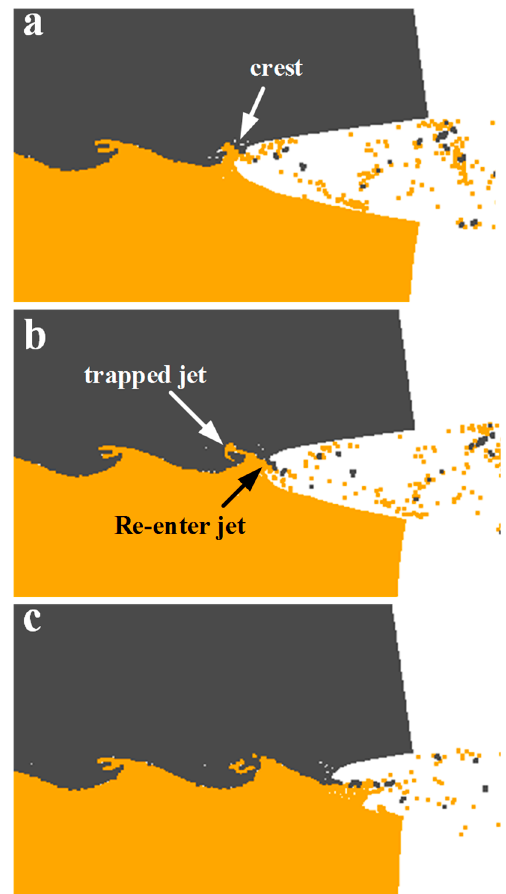
Figure 15. Formation of wave structure during explosive welding simulation: ( a ) the formation of crest; ( b ) the jet divided by the crest; ( c ) the newly formed jet.